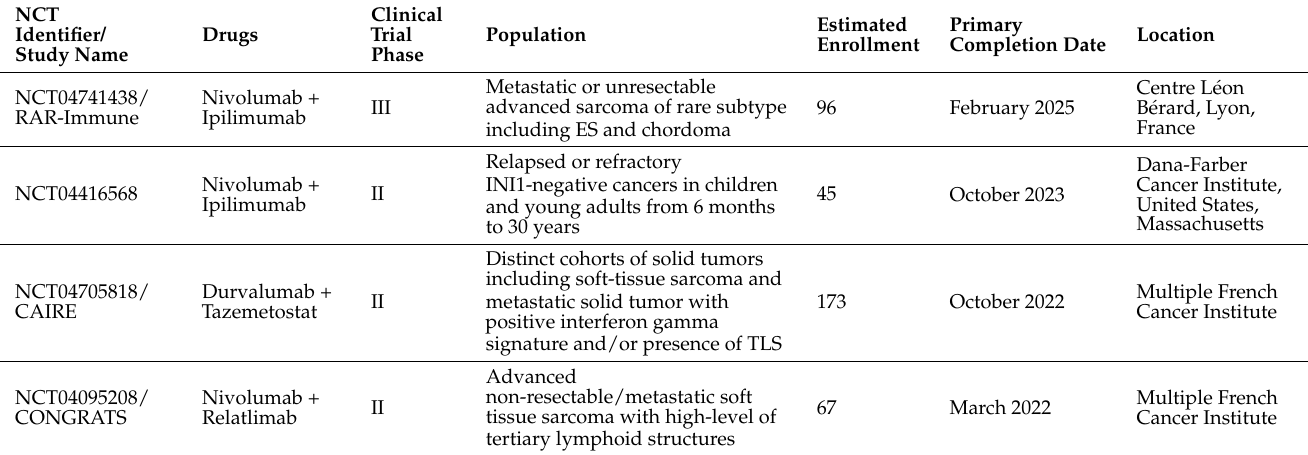
Table 4. Selected ongoing immunotherapy-based clinical trials for SMARCB1-deficient